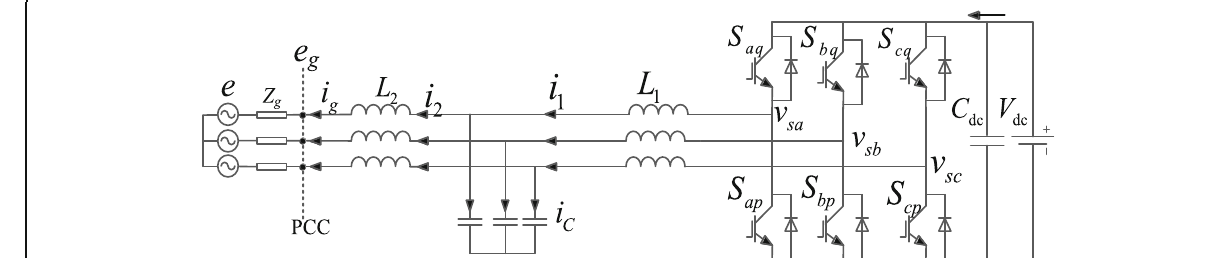
Fig. 1 Mathematical model of LCL type inverter considering grid impedance